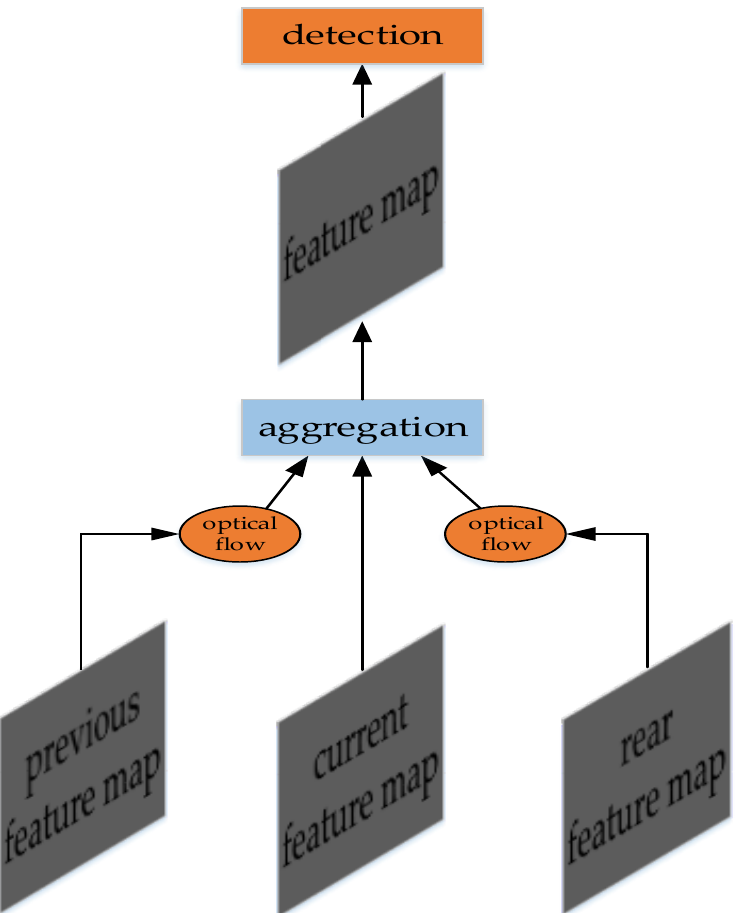
Figure 19. The structure of FGFA. Optical flow is a feature transmission method.